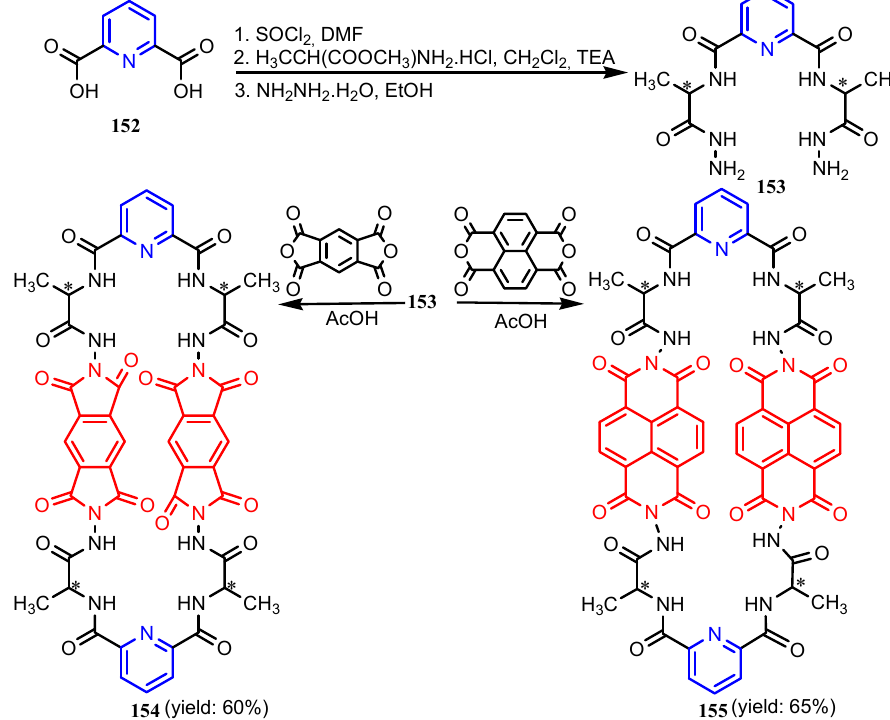
Table 8. Antimicrobial activities of the compounds 154 and 155 [66].